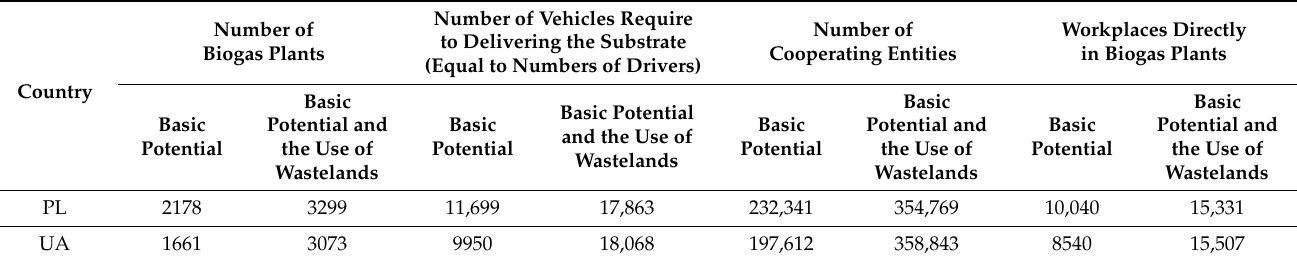
Table 3. The impact of biogas plants on the labor market, transport fleet, and cooperation network. Source: Own study.